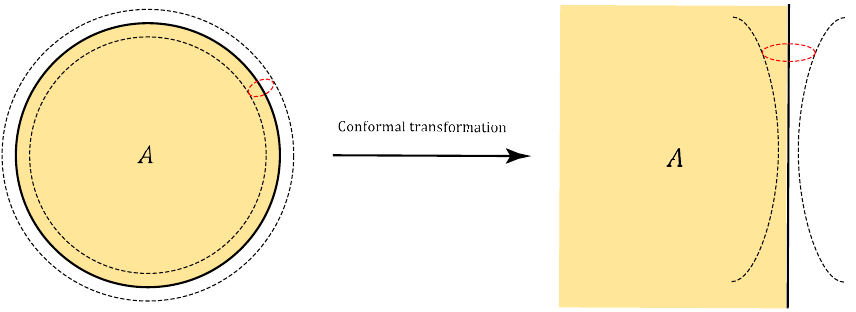
Figure 7 . The UV cut-off tube in two conformally equivalent frames. Left: the UV cut-off tube of constant radius in the original spherical frame. Right: the mapped UV cut-off tube of “trumpet” shape in the Rindler